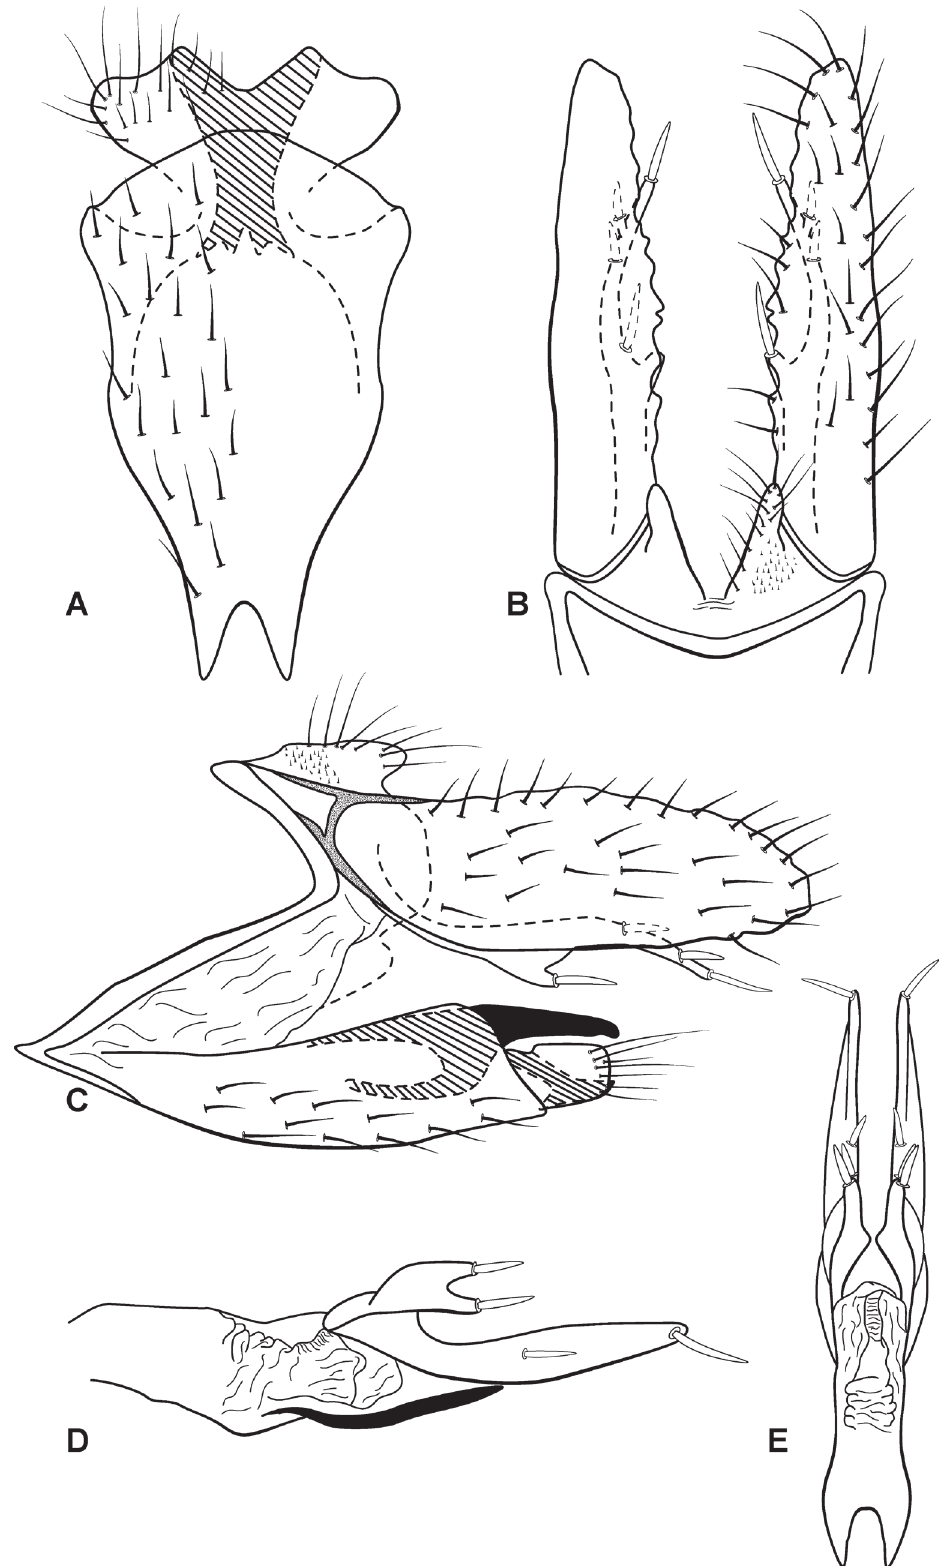
Fig. 15. Austrotinodes amazonensis Flint & Denning, 1989, male genitalia. A . Ventral view. B . Dorsal view. C . Left lateral view. D . Phallic apparatus, left lateral view. E . Phallic apparatus, dorsal